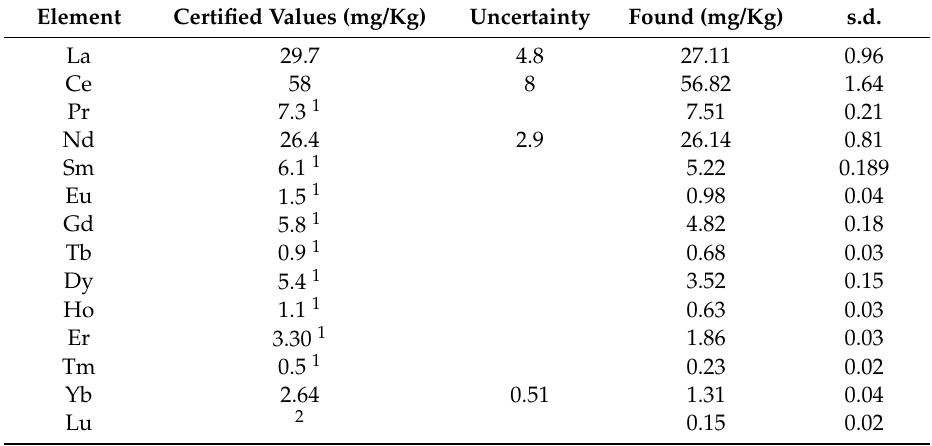
Table 3. Analysis of SRM 2586 certified soil material (trace elements in soil containing lead from